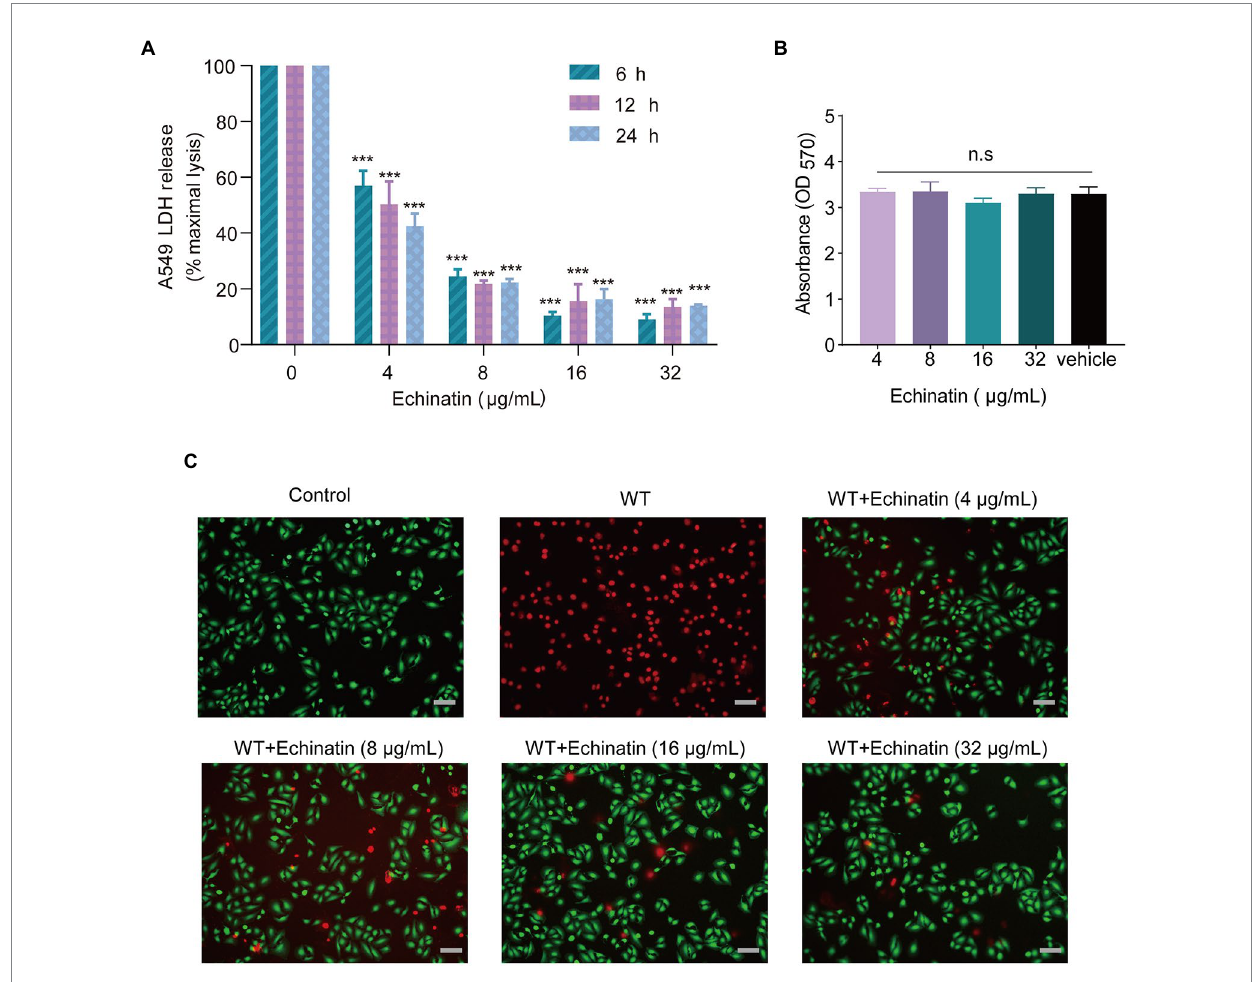
FIGURE 4 Protective effects of echinatin against S. aureus -mediated A549 cell injury. (A) After 24 h of incubation with the indicated concentrations of echinatin, the cell viability of A549 cells was determined using the MTT assay. (B) Different concentrations of echinatin-treated S. aureus -infected A549 cells and an LDH release assay were used to assess cell survival. (C) Echinatin attenuated S. aureus Hla-mediated damage to A549 cells. Live (green)/dead (red) agents were used to detect the survival of A549 cells after S. aureus infection with or without echinatin treatment, and images were acquired by fluorescence microscopy (Scale bar = 50 μ m). Experiments were performed in triplicate. * p < 0.05, ** p < 0.01, and *** p < 0.001 compared to the